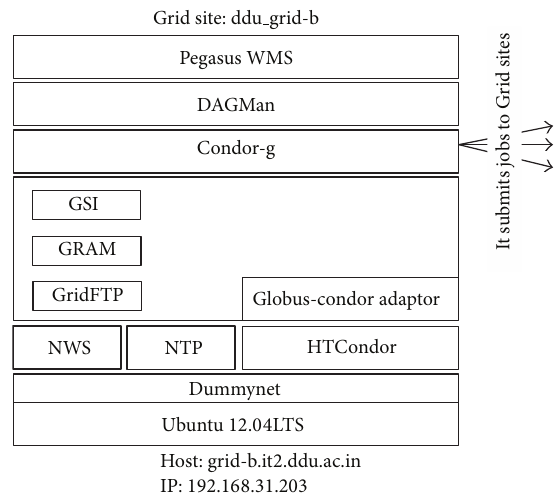
Figure 2: Components in our Grid